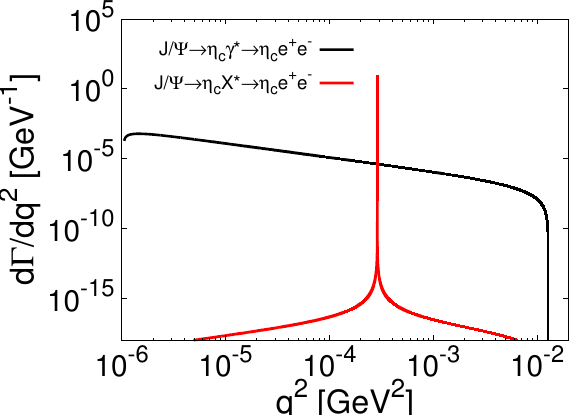
. Input parameters are m e + e −